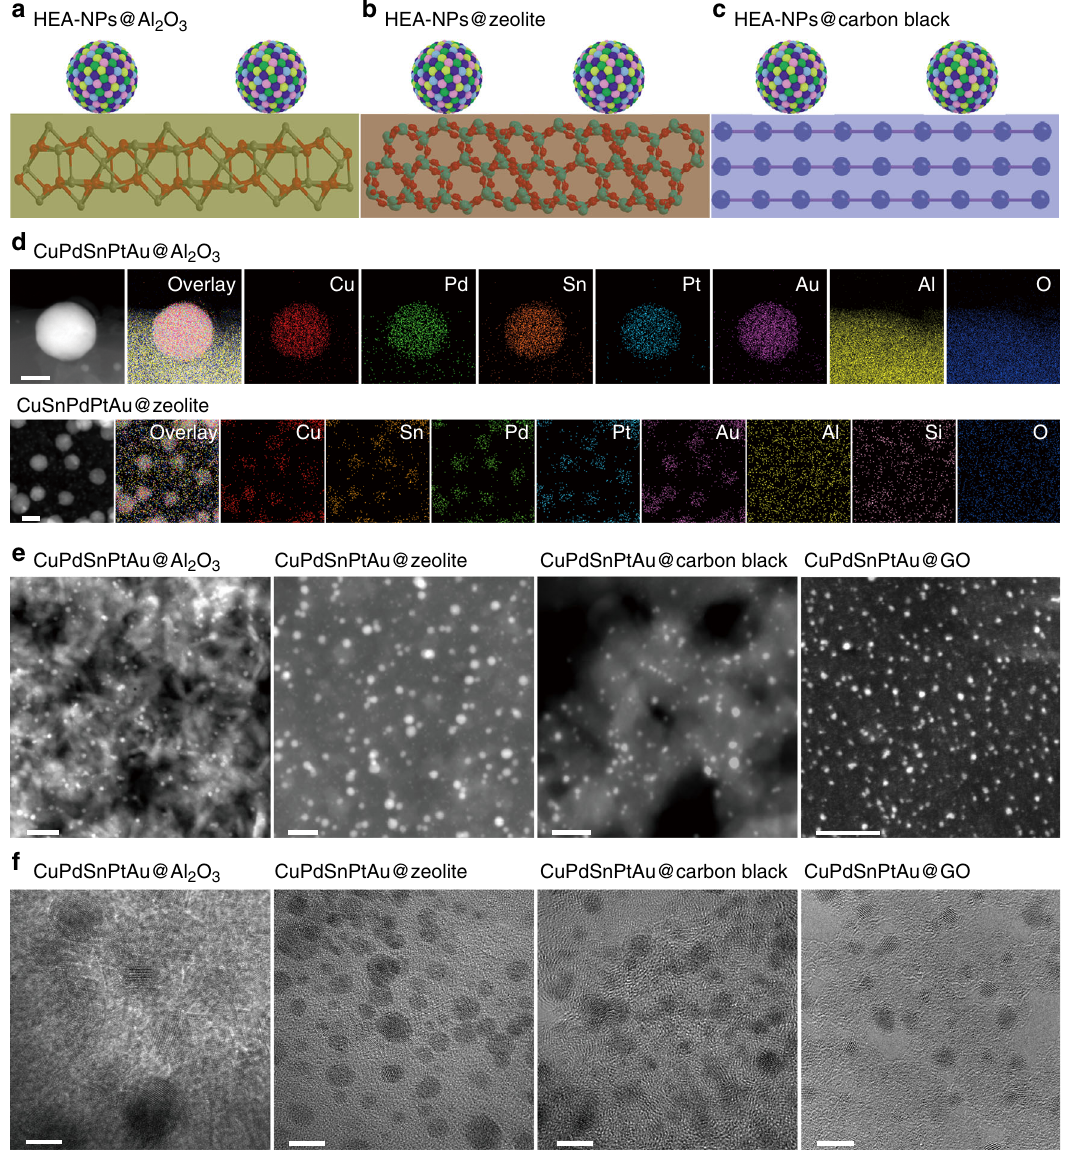
Fig. 3 Supporting HEA-NPs on various supports. The schematic diagrams for HEA-NPs dispersed on γ -Al 2 O 3 ( a ), zeolite ( b ), and carbon black ( c ). d The elemental maps for quinary (CuPdSnPtAu) supported on Al 2 O 3 and zeolite, (The loading of HEA-NPs on γ -Al 2 O 3 and zeolite was 10 wt%). e STEM images revealed that the HEA-NPs synthesized by FMBP strategy were highly dispersed on γ -Al 2 O 3 , zeolite, carbon black, and GO. f HR-TEM images for HEA-NPs supported on γ -Al 2 O 3 , zeolite, carbon black, and GO synthesized by FMBP strategy (The loading of HEA-NPs on supports was 3 wt%). The elements in HEA-NPs have the equal atomic ratio. Scale bar d : 10 nm, e : 20 nm, f : 5